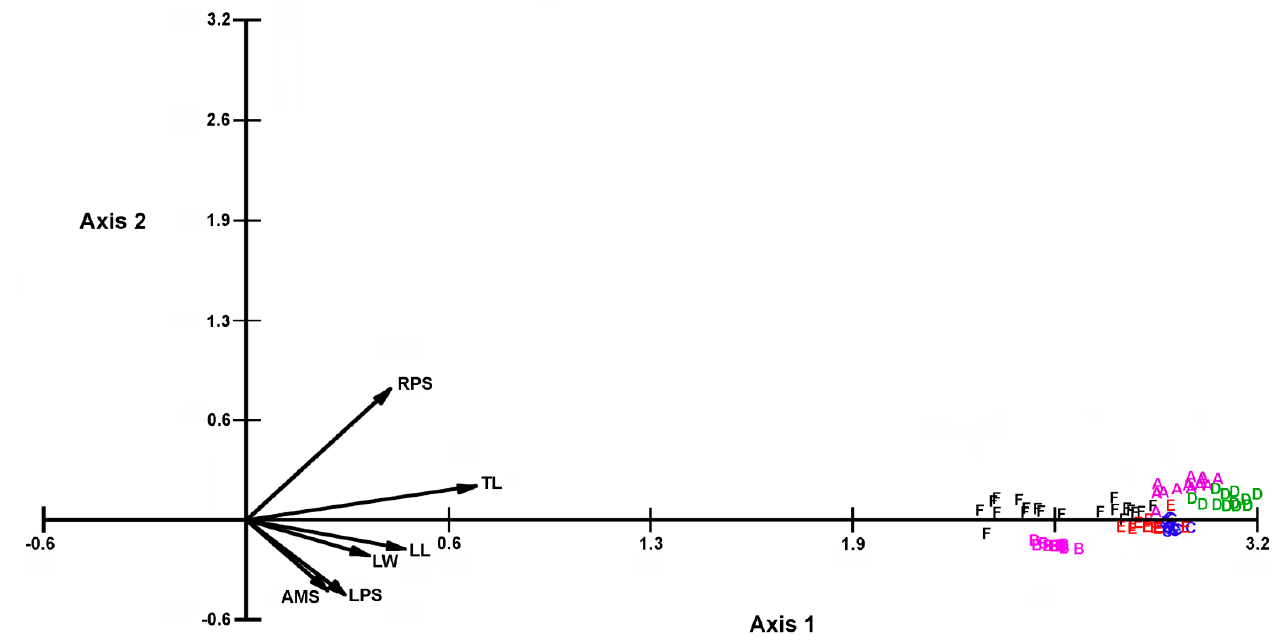
Figure 5. PCA biplot of Keratella populations analyzed. Symbols are as follow: A = ESU2, B = ESU3, C = ESU4, D = ESU1, E = ESU5 and F = ESU6. LT = Total lenght, LL = Lorica lenght, LW = Lorica width, RPS = Right posterior spine, LPS = Left posterior spine, AMS = Antero median spine.